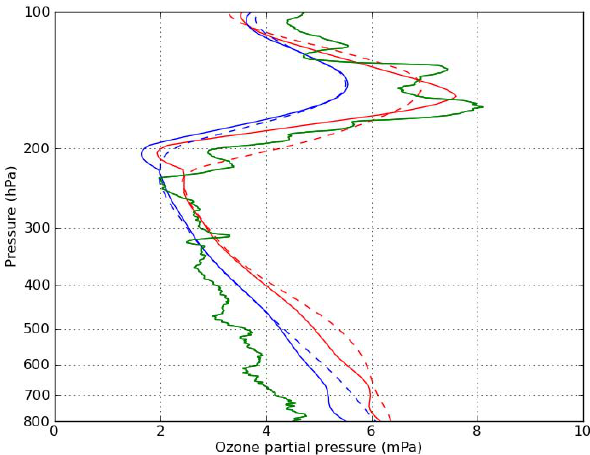
Fig. 6. Ozone profiles in mPa from a sonde over Legionowo (52.4 ◦ N, 21.97 ◦ E, Poland; green line, launched at 11:17UT on 24 June 2009), from the free MOCAGE run (blue lines) and from analyses (red lines). Low resolution (2 ◦ ) and high resolution (0.2 ◦ ) results are represented by dashed and solid lines,